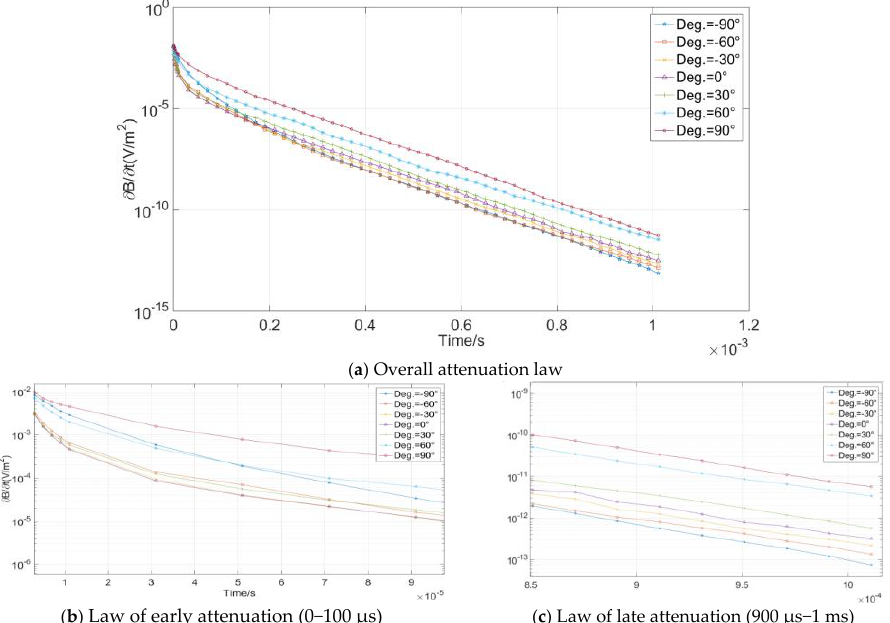
Figure 10. Induced electromotive force attenuation curves of different dip angle collapse columns.